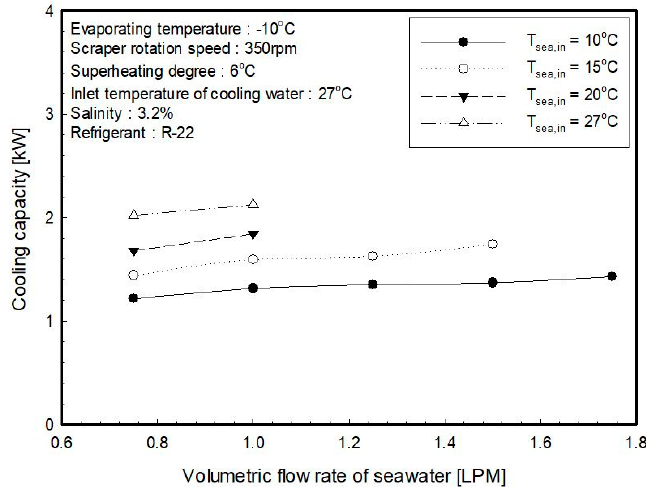
Figure 6. Influence of seawater flow rate on IPF for inlet temperature of seawater.